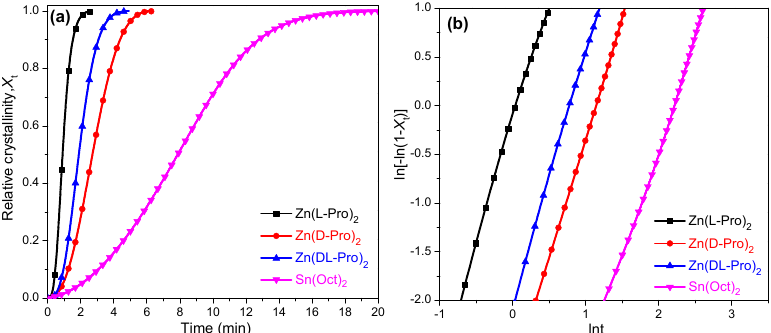
Figure 5. Kinetics analysis of PLLA obtained by Zn(Pro) 2 ( a ) Relative crystallinity as a function of time and ( b ) Avrami plots of isothermally crystallized 125 °C (Sn(Oct) 2 as reference).